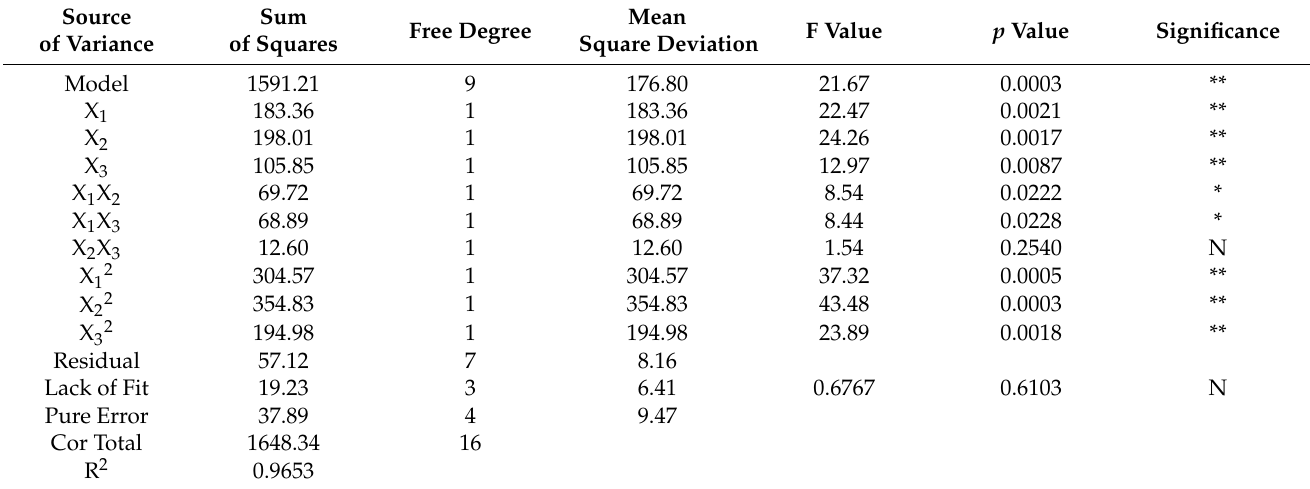
Table 3. Variance analysis of WBY protein extraction